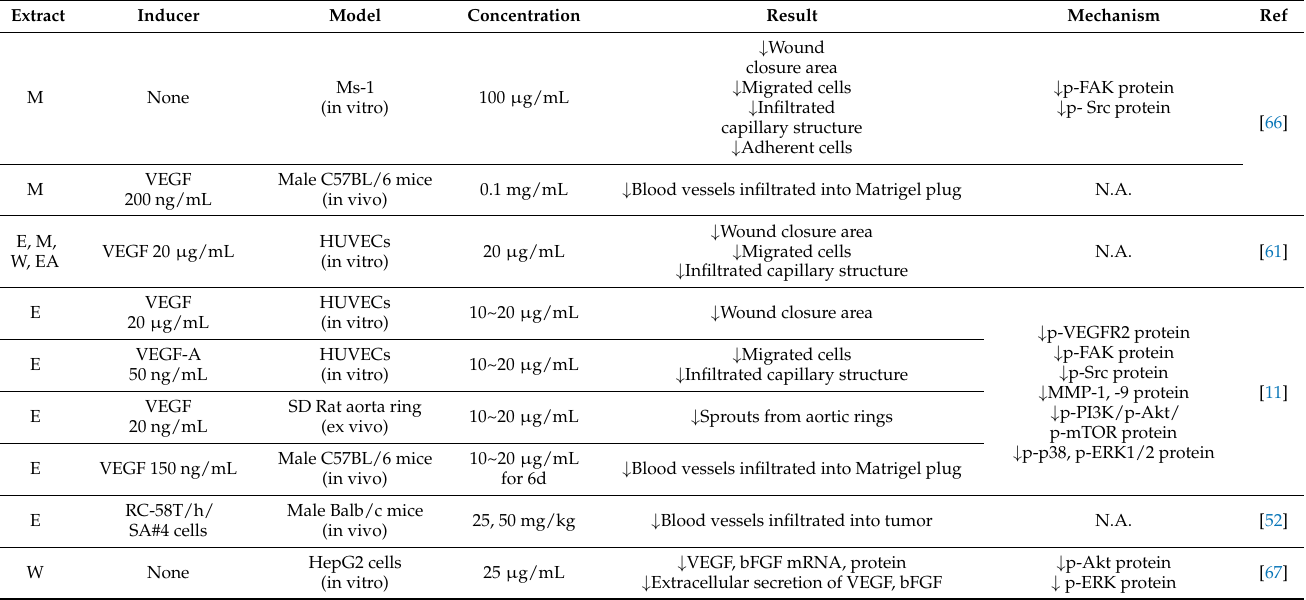
Table 2. Anti-angiogenic effects and molecular mechanisms of O.